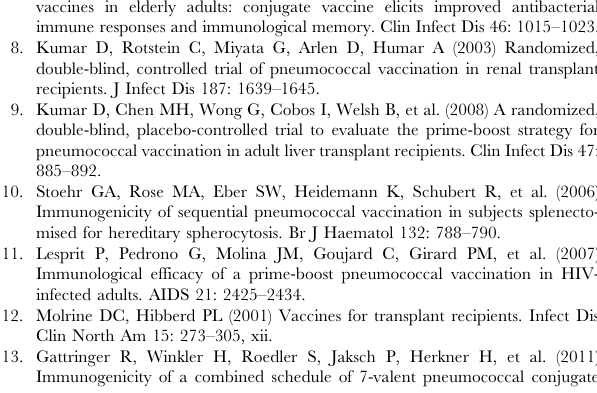
Figure S2 Geometric mean concentration (GMC) of 10 serotype-specific antipneumococcal IgG serum antibod- ies at baseline (A), 8 weeks (B) and 1 year (C) after vaccination with 7vPnC and PPV, and 8 weeks after revaccination with PPV (D). Note that the Y-axis scale for serotype 14 differs from the other serotypes (with 95% confidence interval). Serotypes 1, 5, and 7F are not included in the 7vPnC vaccine. (TIF) Figure S3 Fold increase of antibody response in the 7vPnC/PPV group 8 weeks after revaccination com- pared with the immune response of the PPV group 8 weeks after vaccination. Fold increase in ELISA concentra- tions were determined by dividing the post-vaccination concen- trations by the pre-vaccination concentrations in each group. (TIF) Figure S4 Fold increase of antibody response compared with baseline 8 weeks after revaccination with PPV. Fold increase in ELISA concentrations were determined by dividing the final post-vaccination concentrations by the pre-vaccination concentrations in each group. (TIF) Figure S5 Percentage of subjects responding to each serotype 8 weeks after vaccination on the basis of serotype-specific antibody response. Serotypes 1, 5, and 7F are not included in the 7vPnC vaccine. a) after first vaccination; b) after second